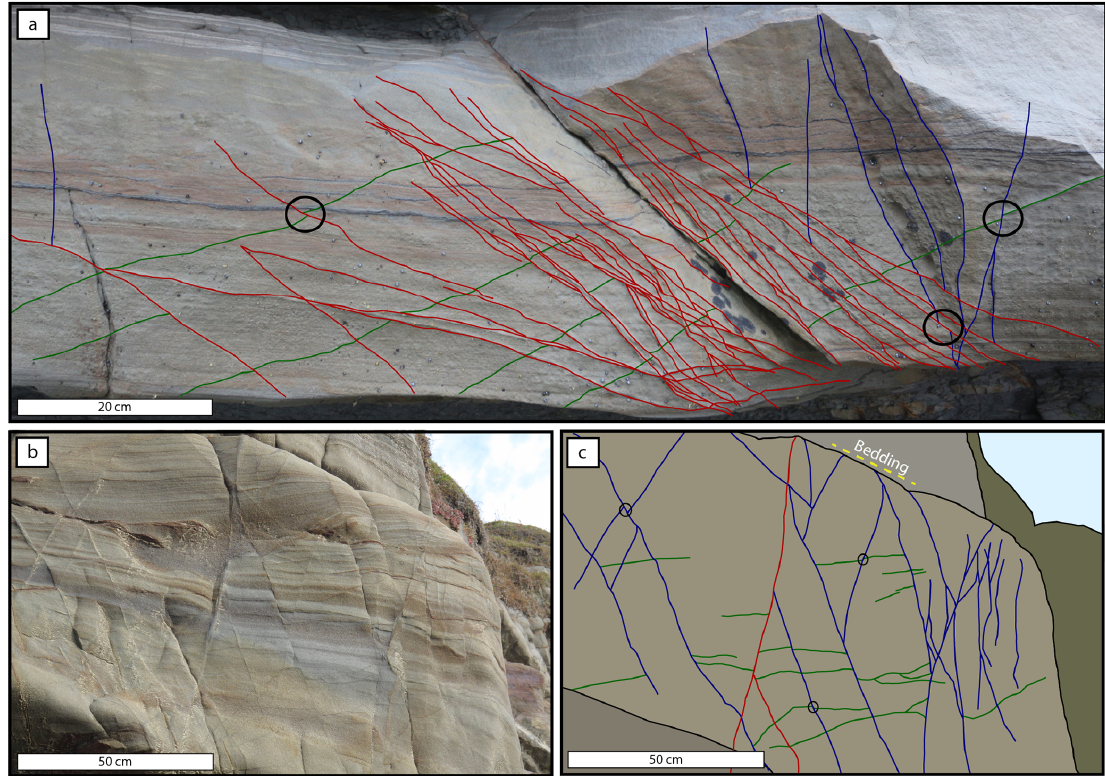
Figure 5. Examples of overprinting criteria used to determine the relative timing of each deformation phase. (a) Multiple generations of deformation band located within a D3 damage zone. The digitisation indicates the different generations of deformation band with overprints used to generate relative timing highlighted by black circles (green denotes D1, blue denotes D2, and red denotes D3). (b) Multiple gen- erations of deformation band with overprints. A line drawing to highlight the overprints observed in panel (b) is shown in panel (c) (green denotes D1, blue denotes D2, and red denotes D3). Black circles in panel (c) signify some examples of overprints.